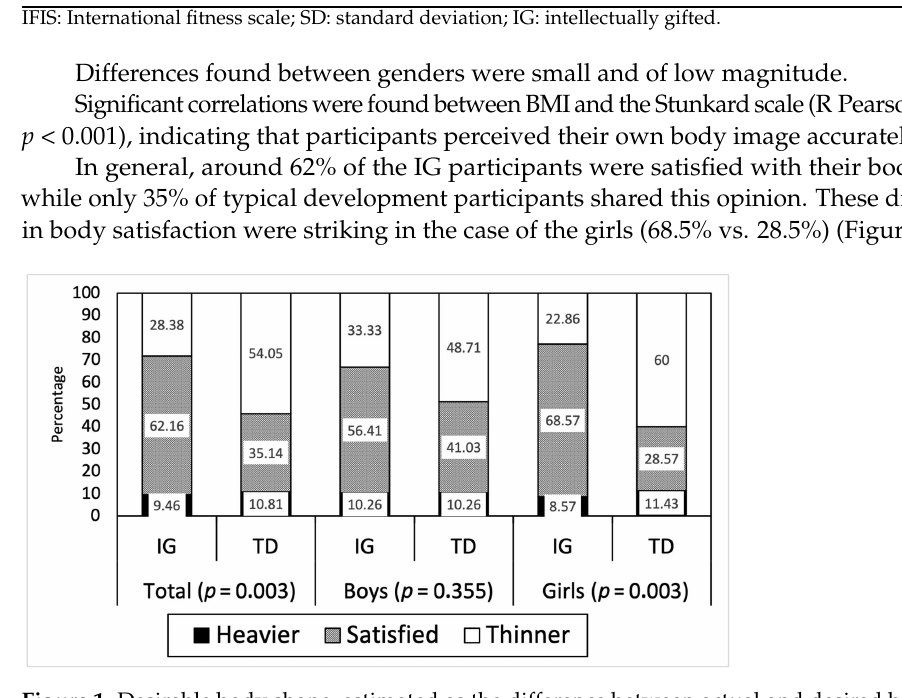
Figure 1. Desirable body shape, estimated as the difference between actual and desired body shape. IG: intellectually gifted; TD; typical development. 4. Discussion This study aimed to compare PA prevalence, fitness levels, and body image between IG and typically developed children. We found that IG girls were less active than typically developed girls, while no differences were observed regarding self-perceived and objec- tively assessed PF between groups. The obtained results also indicated that IG children